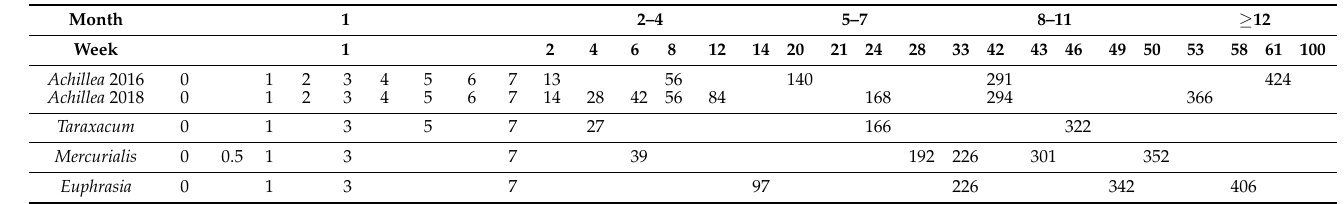
Table 1. Sampling schedule for the preparations of Achillea , Taraxacum , Mercurialis , and Euphrasia during the fermentation period. Sampling times of the four MPs are provided as days after start (0). Fermentation of Achillea 2016 was conducted with recurring cooling (according GHP) and “warm” treatment (for details, see